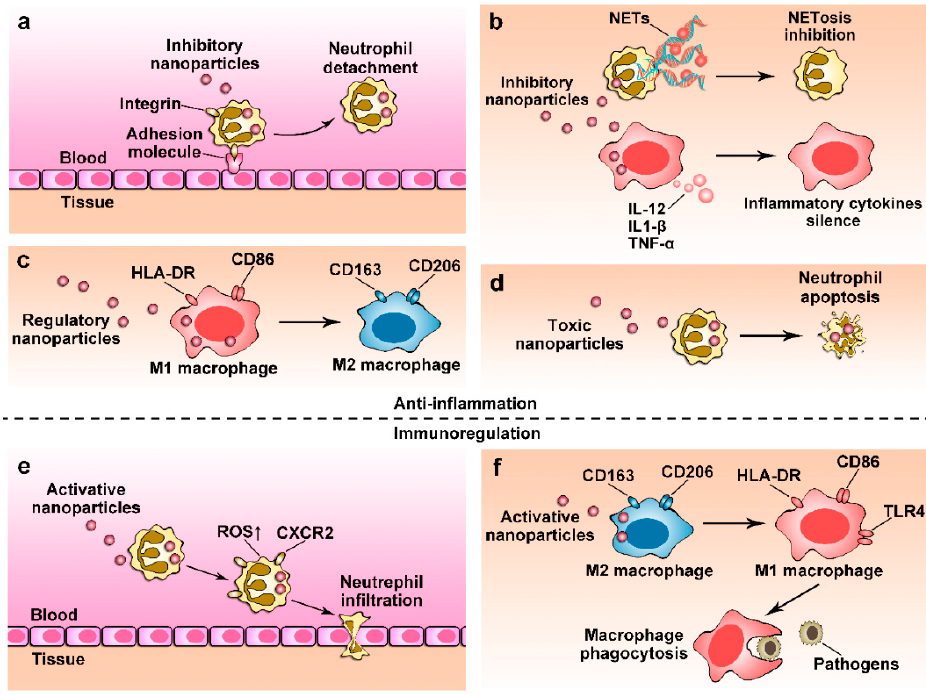
Figure 3. Targeting neutrophils and macrophages using nanoparticles for immunotherapies in inflammatory disorders. ( a ) Albumin nanoparticles loaded with piceatannol inhibit the neutrophil adhesion to endothelium, thus blocking neutrophil infiltration [93]. ( b ) Nanoparticles inhibit the functions of activated neutrophils and macrophages to reduce pro-inflammatory factors [149] and